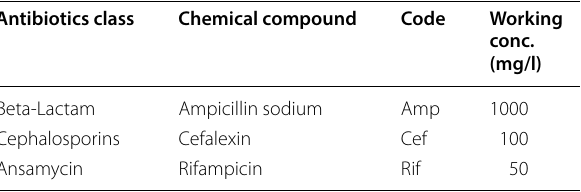
Table 2 Antibiotics, their classes and concentrations used to control HLB in infected Kinnow orchard